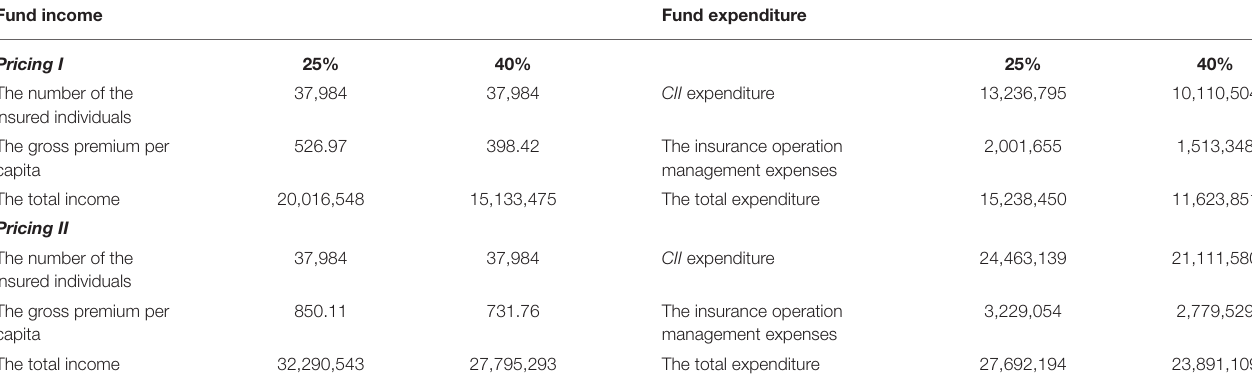
TABLE 12 | The fund balance of the CII in the ATP